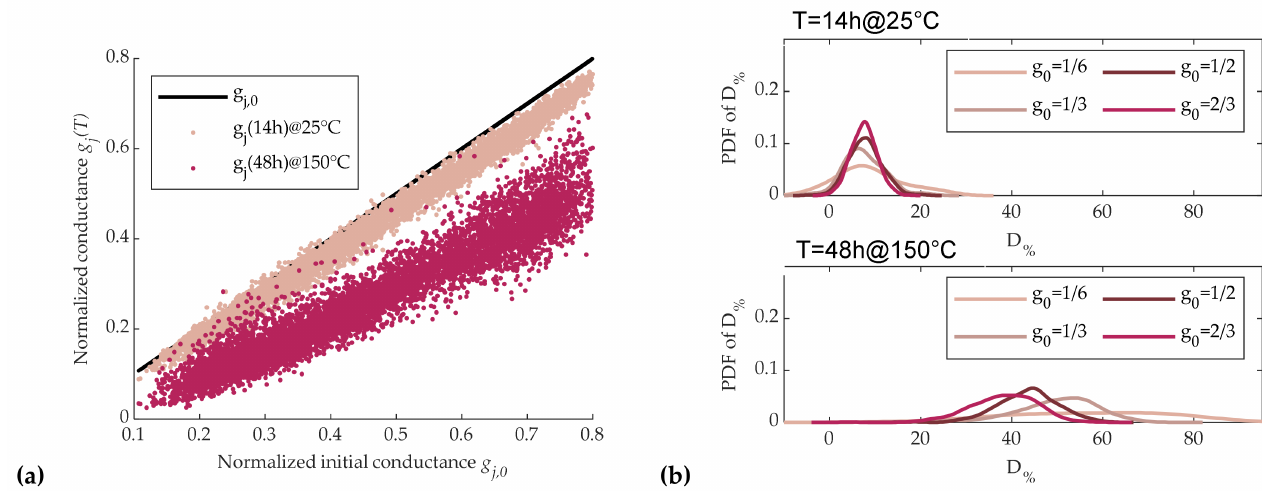
Figure 14. Effects of SSC sequence as described in Figure 9.d and 11.d with A R = 3A R0 . ( a ) Cells conductance as a function of the initial normalized conductance after 14 hours at room temperature, and after 48 hours at 150 ◦ C. ( b ) Probability distribution of D % obtained with the SSC programming sequence. Different curves refer to different target conductances with ± 10% tolerance.